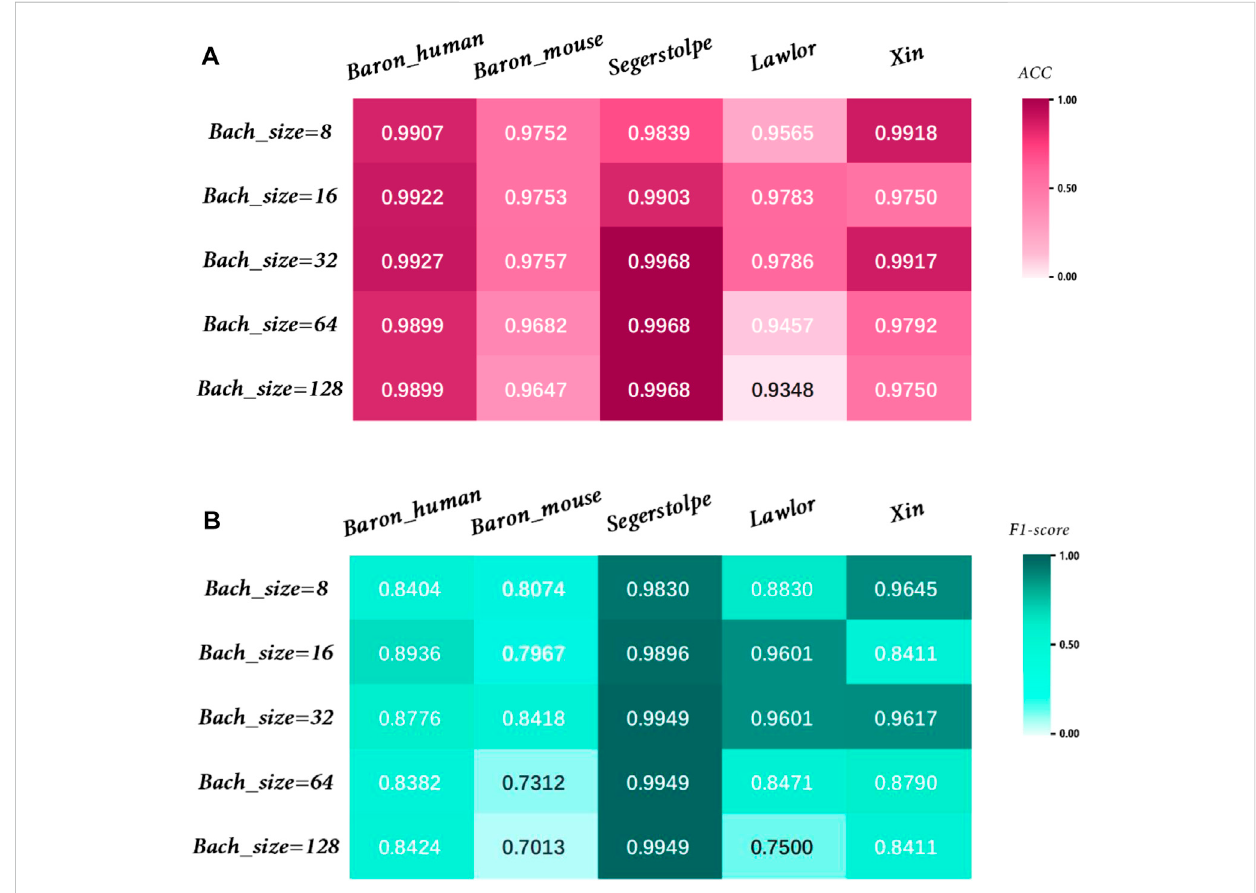
FIGURE 10 Performance analysis of MulCNN under different Bachsize. (A) Accuracy comparison; (B) F1 score